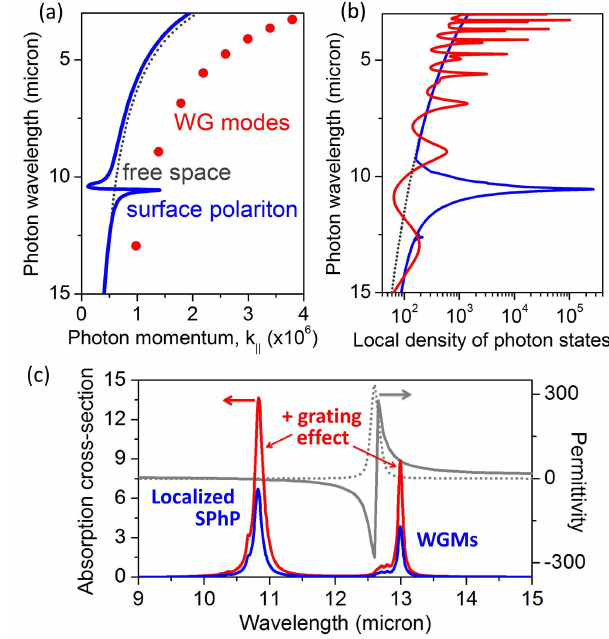
Fig. 3. LDOS engineering with confined optical modes having high photon momentum. (a) Dispersion characteristics of quantized multiple-degenerate whispering gallery modes in a 5 micron diam- eter TiO 2 microsphere (red dots) and of a surface phonon polariton mode on a SiC-air interface (solid blue line). (b) LDOS frequency spectrum on the surface of the microsphere (red solid line) and on the SiC-air interface (blue solid line). The free space photon disper- sion and the free-space photon DOS are shown for comparison as dotted gray lines in (a) and (b), respectively. (c) The absorption efl- ciency of an 800-nm diameter SiC microsphere (blue solid line) and of a periodic chain of 10 microspheres (solid red line) as a function of photon wavelength. The gray lines show the spectral dispersion of the dielectric permittivity for SiC (Re( ε )-solid line, Im( ε )-dotted). The resonant peaks correspond to the excitation of localized sur- face phonon-polariton modes at ~10–11 micron and of trapped whispering gallery modes at ~13